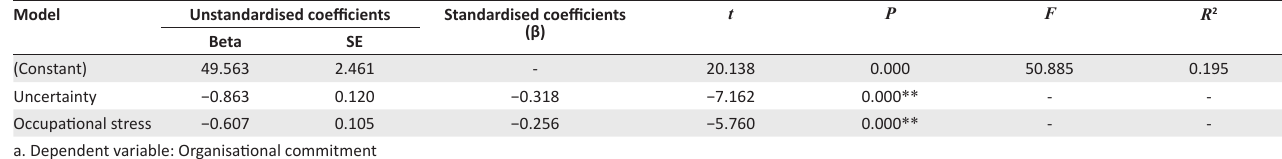
TABLE 6: Multiple regression with organisational commitment as the dependent variable and occupational stress and uncertainty as the independent variable. Model